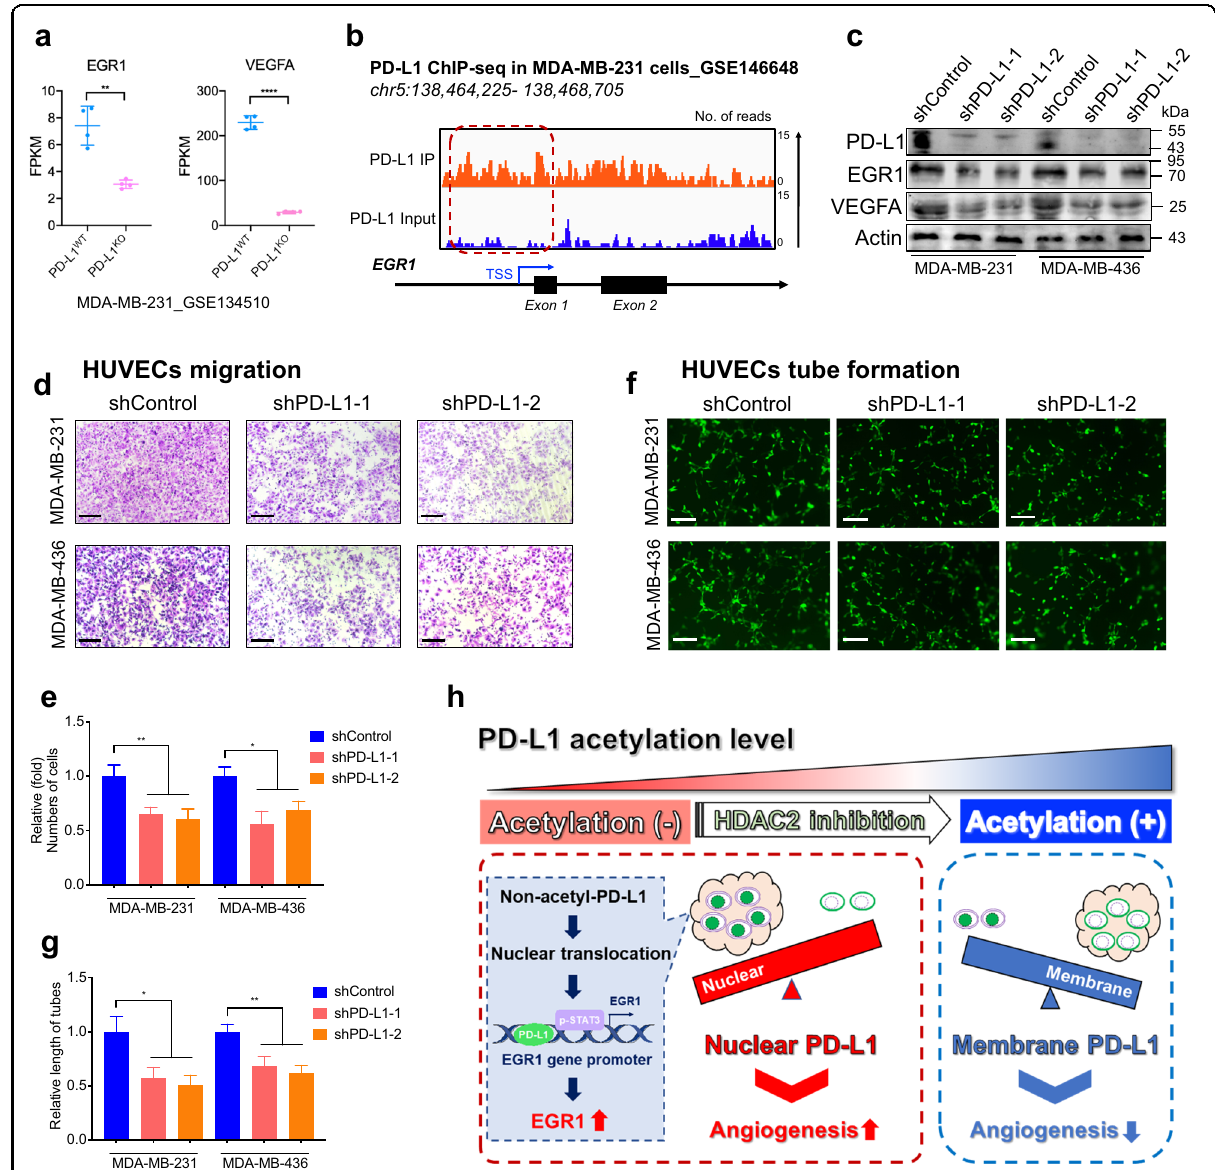
Fig. 8 Nuclear PD-L1 enhanced EGR1 expression and angiogenesis in breast cancer. a FPKM levels of EGR1 and VEGFA from RNA-seq analysis in breast cancer cell line MDA-MB-231 after PD-L1 knockout (GSE134510). n = 4. Data are presented as means ± SD. Two-tailed unpaired Student ’ s t -test. b IGV tracks for EGR1 from PD-L1 ChIP-seq analysis in breast cancer cell line MDA-MB-231 (GSE146648). c Western blot images showing the protein levels of PD-L1, EGR1 and VEGFA in PD-L1-silenced breast cancer cells and control cells. d HUVECs migration assay to investigate the effect of conditional medium from PD-L1-silenced breast cancer cells and control cells on the migration ability of HUVECs. Scale bars, 50 µm. e Statistical analysis of the HUVECs migration assay. n = 3. Data are presented as means ± SD. Two-tailed unpaired Student ’ s t -test. f HUVECs tube formation assay to investigate the effect of conditional medium from PD-L1 silenced breast cancer cells and control cells on HUVECs tubule formation. Scale bars, 50 µm. g Statistical analysis of the HUVECs tube formation assay. n = 3. Data are presented as means ± SD. Two-tailed unpaired Student ’ s t -test. h Schematic diagram of pro-angiogenic mechanism of nPD-L1 in UM. We demonstrated that PD-L1 nuclear translocation in UM facilitated angiogenesis by coactivating EGR1 expression with p-STAT3. This elevated nPD-L1 level was mediated by HDAC2-dependent deacetylation in UM cytoplasmic component, and the pellet was resuspended qRT-PCR in 50 µL of nuclear protein extraction reagent for the Total RNA was isolated from cultured cell samples by nuclear fraction. The isolated fractions were processed for the EZpress RNA Puri fi cation Kit (EZBioscience, B0004) western blot analysis. according to the manufacturer ’ s instructions. Then,